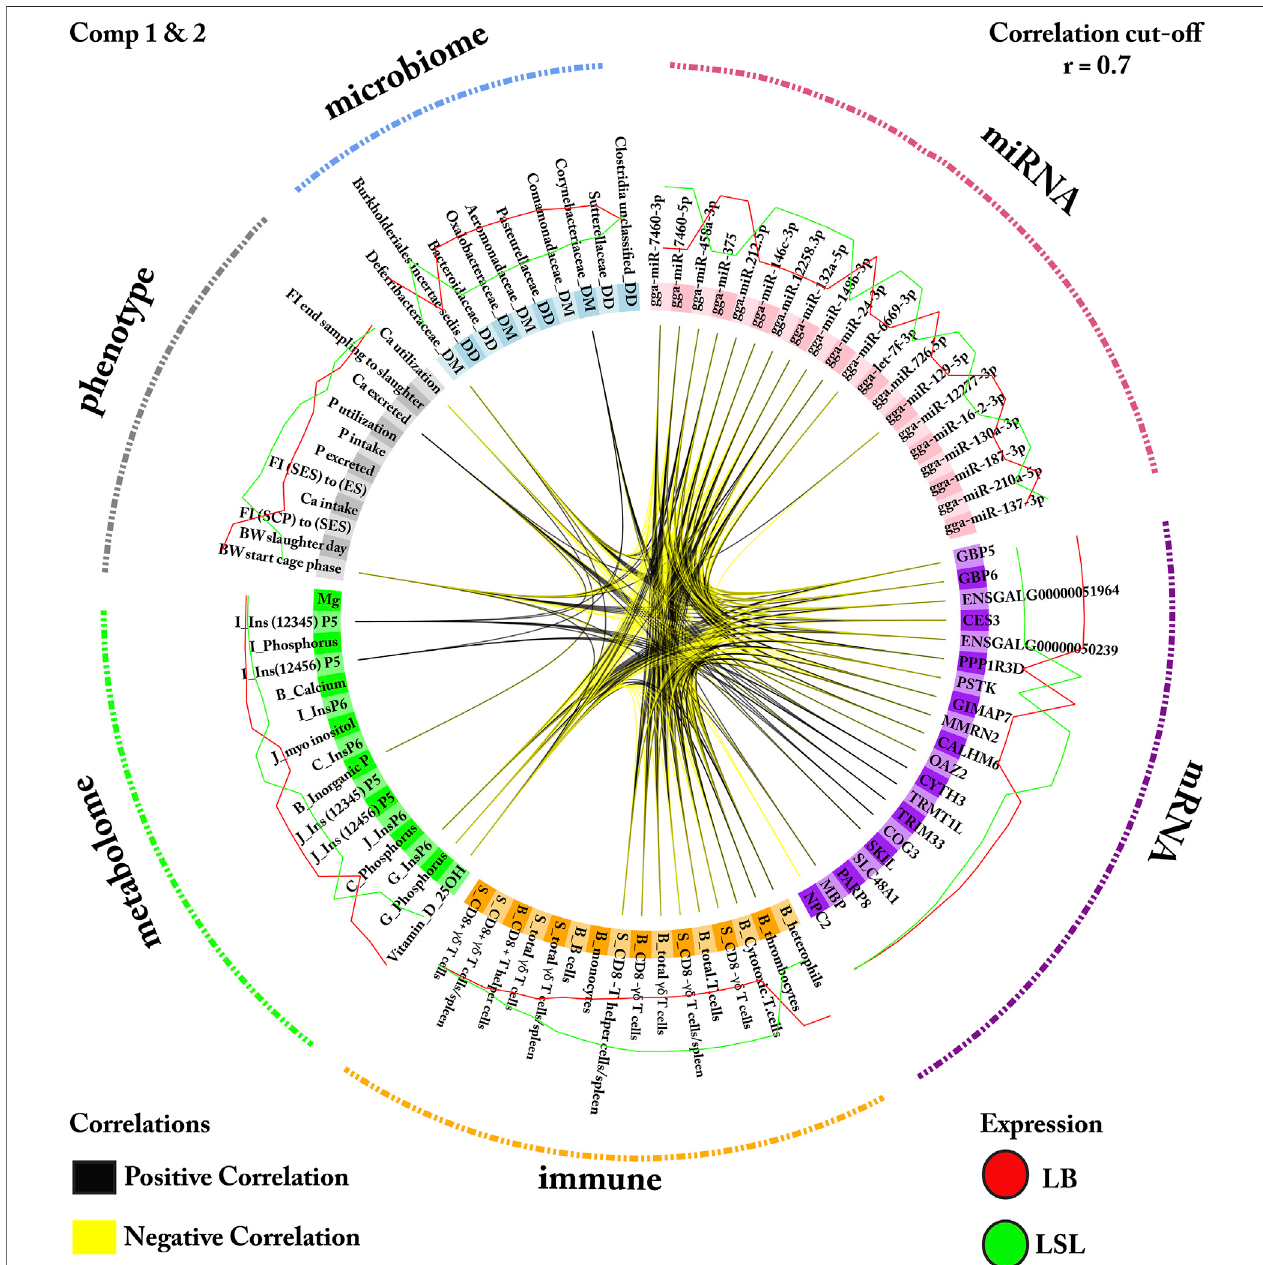
FIGURE 5 | Variable plot of miRNAs, mRNAs, phenotypic, immune traits, metabolites, and microbes related to LB and LSL strains. Circos plot demonstrates the bio-signature from multiple datasets over the two components. The selected biomarkers were represented in the inner circle. Similarly, the pink, purple, orange, green, gray, and blue dashed lines outside the Circos indicate each data type. The black link suggests a positive correlation, while the yellow link depicts a negative correlation. The red and green lines represent the feature expression level in LB and LSL, respectively.